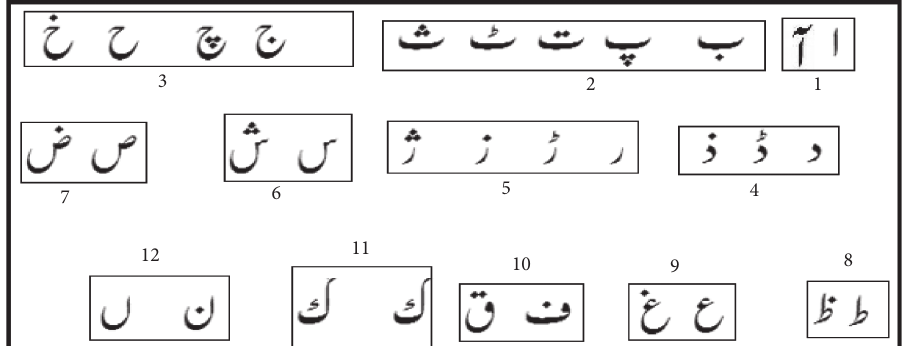
Figure 8: Grouping of Urdu characters having shape